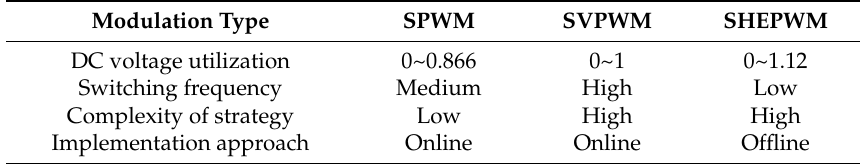
Table 1. Comparison of sinusoidal pulse-width modulation (SPWM), space vector pulse-width modulation (SVPWM), and selected harmonic elimination pulse-width modulation